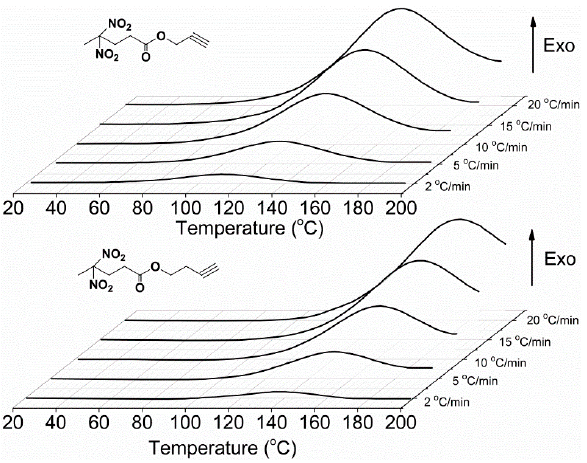
Figure 4. Dynamic DSC curves of PDNP ( n = 1)/PGT ( top ) and BDNP ( n = 2)/PGT ( bottom ) mixtures at different heating rates.